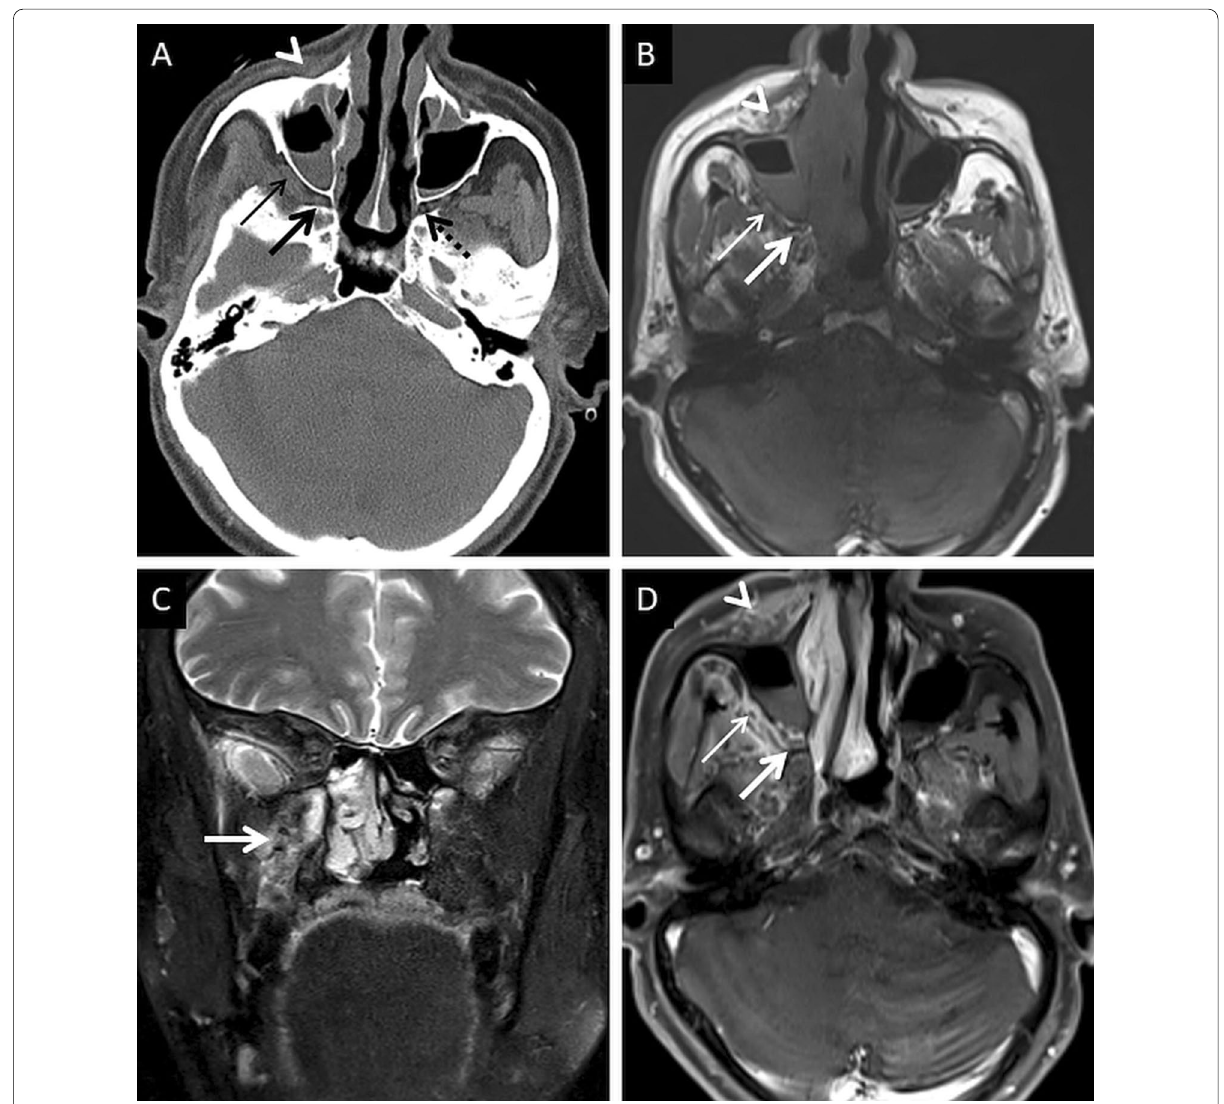
Fig. 9 PPF involvement in ROCM. Unenhanced axial CT scan of the brain ( a ) reveals soft tissue within the right PPF (thick arrow). Note the normal fat density and branches of the internal maxillary artery seen in the contralateral, uninvolved PPF (dotted arrow). Soft tissue is also noted in the right retro-antral fat (thin arrow) and the right anterior periantral fat (arrow head) as well. Based on the imaging signs, the possibility of ROCM was suggested and a prompt CE MRI of the neck was performed. Unenhanced axial T1W ( b ) and coronal T2-FS ( c ) images of the neck confirm the presence of soft tissue in the right PPF (thick arrows in b , c ), right retro-antral fat (thin arrow in b ) and right anterior periantral fat (arrow head in b ). CE FS axial T1W image ( d ) reveals heterogeneous enhancement of the soft tissue in the right PPF (thick arrow) as well as in the right retro-antral fat (thin arrow) and right anterior periantral fat (arrow